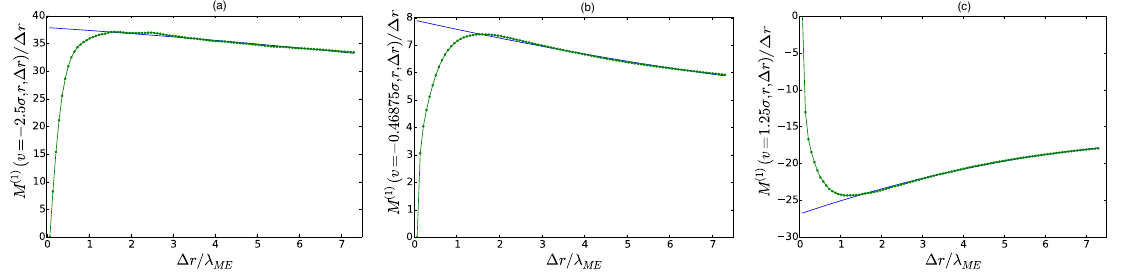
Figure 10. Conditional moments of first order divided by scale separation ∆ r , M ( 1 ) ( v , r ; ∆ r ) / ∆ r for r = L /2, ( a ) v 1 = − 2.5 σ ∞ , ( b ) v 1 = − 0.46875 σ ∞ , ( c ) v 1 = 1.25 σ ∞ and variable ∆ r . The fits correspond to polynomials of second order in ∆ r for ∆ r > λ ME . Note that the ∆ r -axis has been rescaled by the Markov–Einstein-length λ ME and the conditional moment drops to zero for ∆ r < λ ME